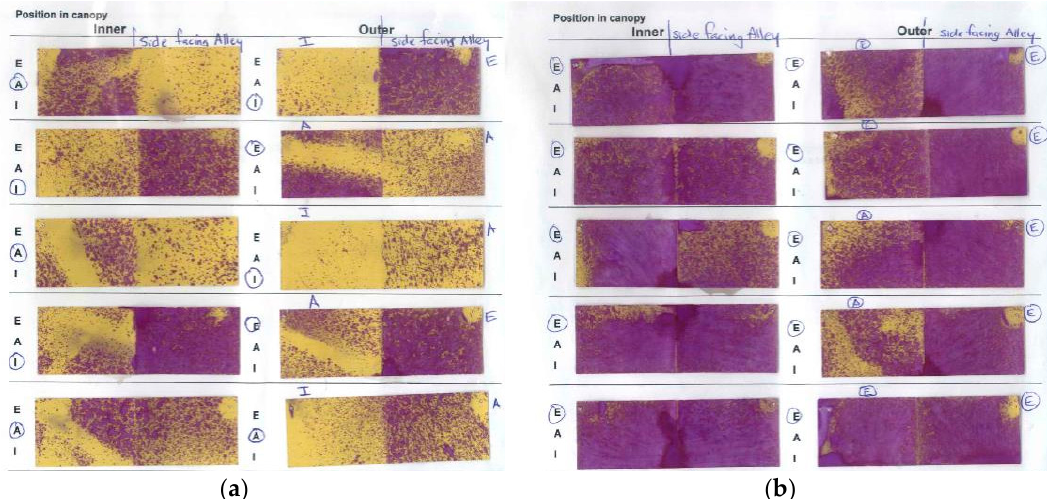
Figure 5. Moisture-sensitive papers indicating spray deposition in Hawke’s Bay, Season iii, under ( a ) standard canopy density (SCD, with approximately 26% bunch exposure); ( b ) low canopy density (LCD, with approximately 80% bunch exposure). The paper turns from yellow to purple when wet. The column of spray papers on the left-hand side in each picture indicates papers positioned on bunches on the inside of the canopy and the column on the right-hand side shows papers positioned on grape bunches on the outside the canopy. E = excellent spray coverage, A = adequate coverage, I = inadeqaute coverage, and the circled value represents the score given to that particular moisture-sensitive